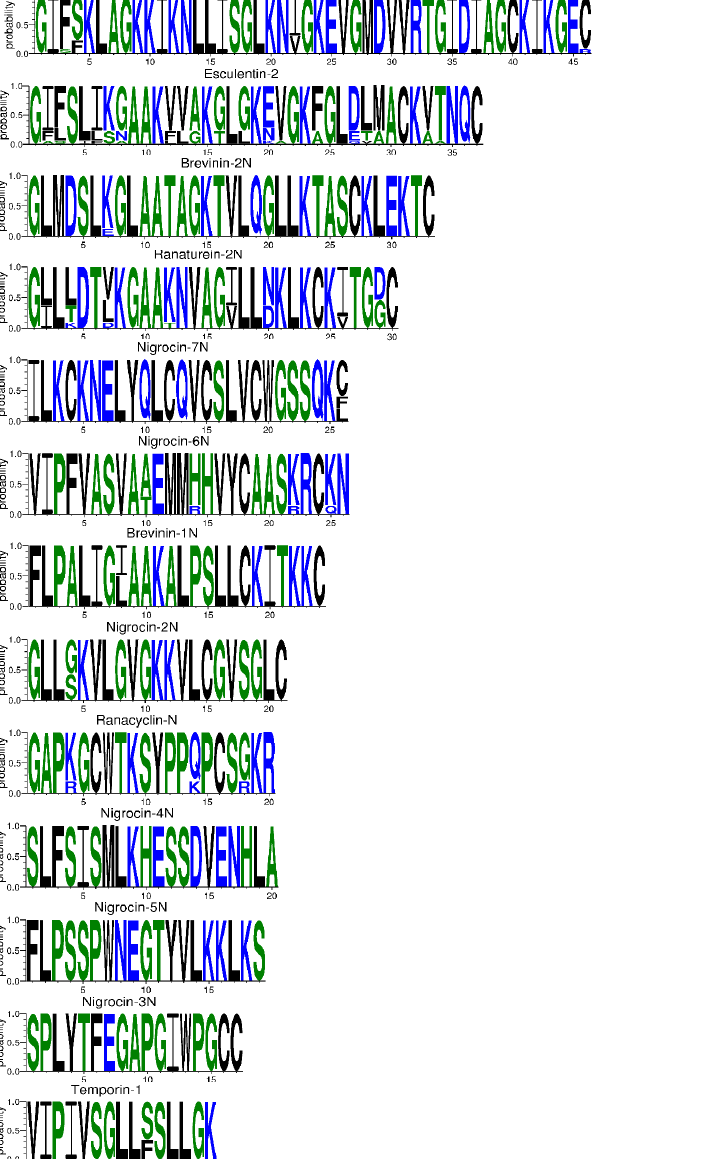
Figure 11. The primary structure of mature peptides of 13 antimicrobial peptide (AMP) families from P. nigromaculatus . The blue letters represent hydrophilic residues, including Arginine (R), Lysine (K), Aspartic acid (D), Glutamic acid (E), Asparagine (N), Glutamine (Q); the green letters represent neutral residues, namely Serine (S), Glycine (G), Histidine (H), Threonine (T), Alanine (A), and Proline (P); the black letters represent hydrophobic residues, including Tyrosine (Y), Valine (V), Leucine (L), Isoleucine (I), Phenylalanine (F), Tryptophane (W), Methionine (M), and Cysteine